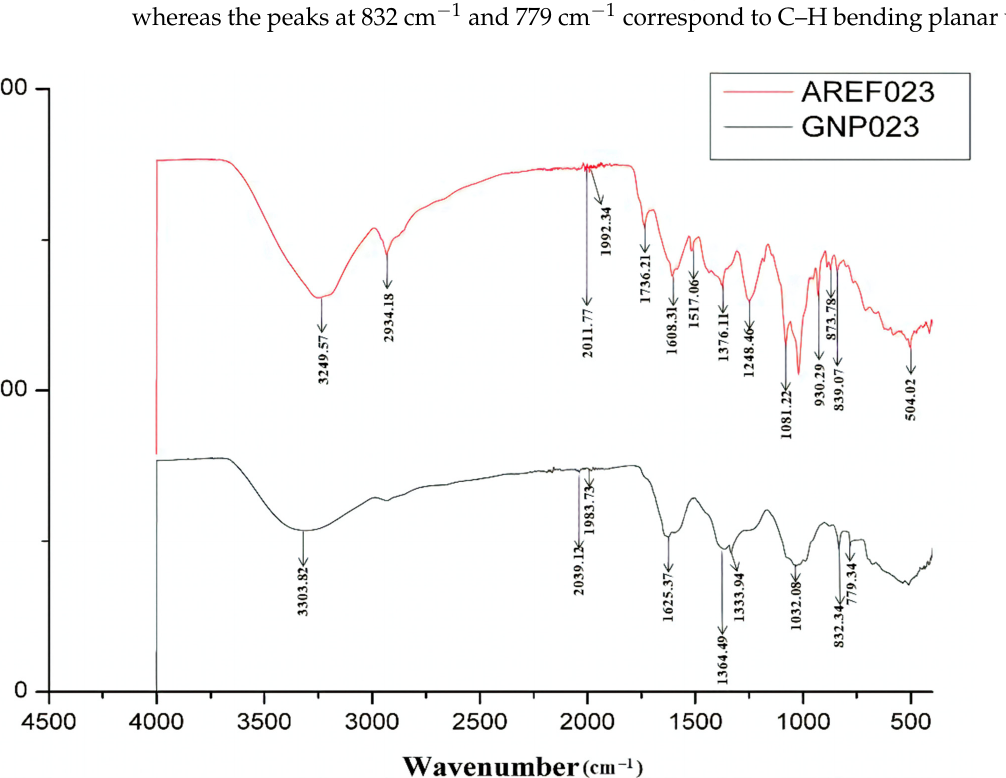
Figure 5. FTIR analysis spectra of A. terreus AREF023 extract and gold nanoparticles